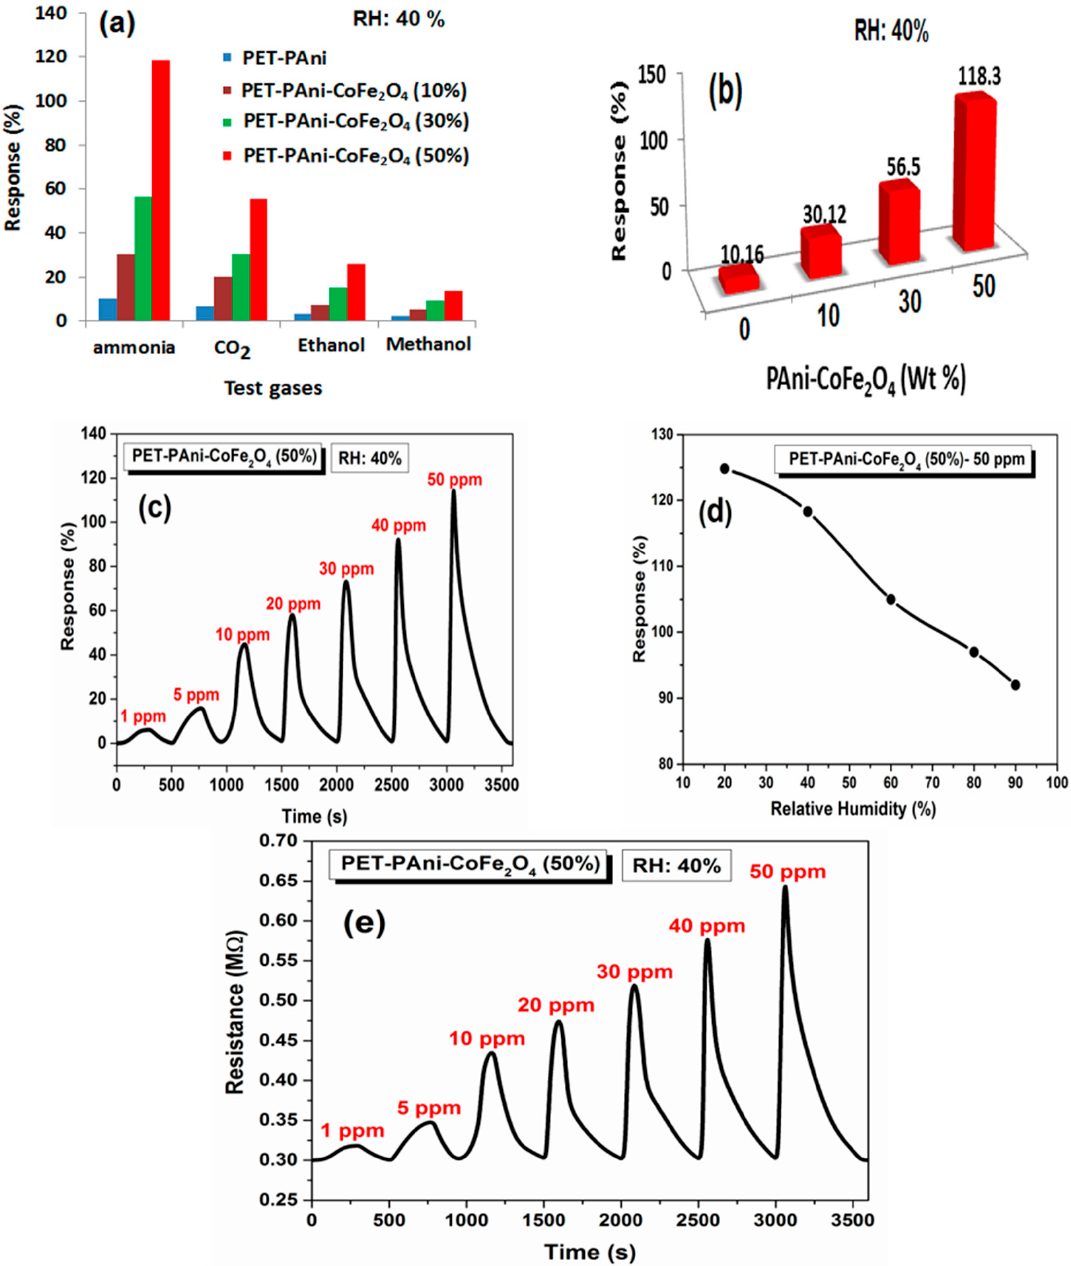
Figure 12. ( a ) Selectivity of PET-PAni and PET-PAni-CoFe 2 O 4 films towards different test gases at 50 ppm, ( b ) Response of PET-PAni and PET-PAni-CoFe 2 O 4 films towards 50 ppm NH 3 gas, ( c ) Response of PET-PAni-CoFe 2 O 4 (50%) to 1–50 ppm of NH 3 , ( d ) Humidity study of PET-PAni-CoFe 2 O 4 (50%) at 50 ppm NH 3 gas and ( e ) Resistance values of PET-PAni-CoFe 2 O 4 (50%) to 1–50 ppm of NH 3 .